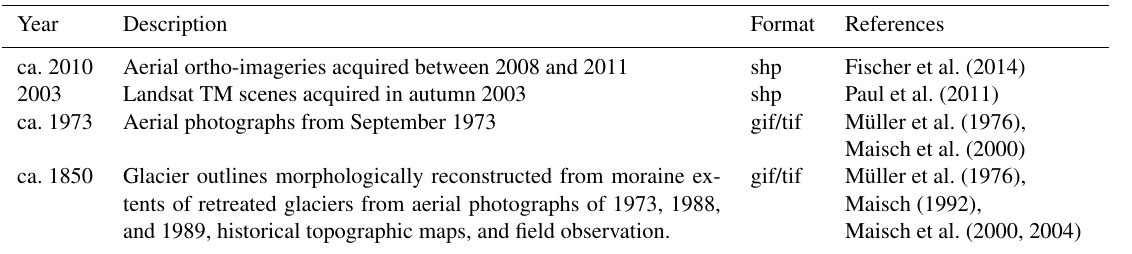
Table 1. Glacier inventories used for large-scale